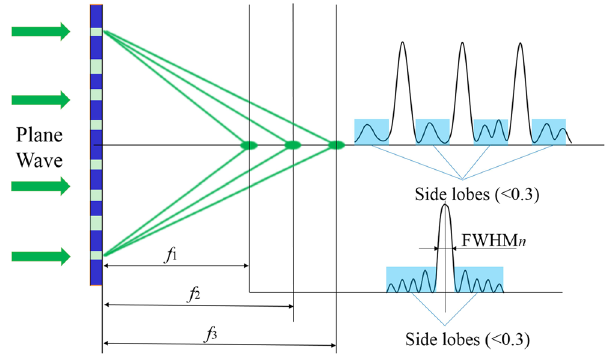
Figure 2. The strategy to construct the multifocal light